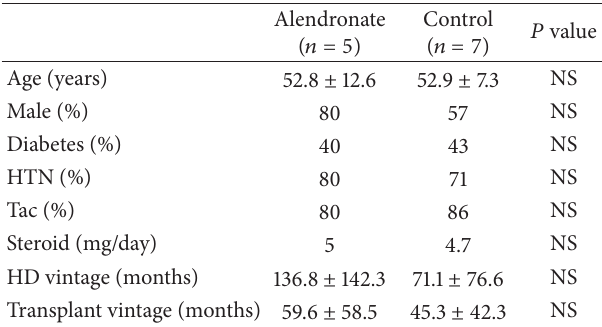
Table 1: Baseline characteristics of patients.